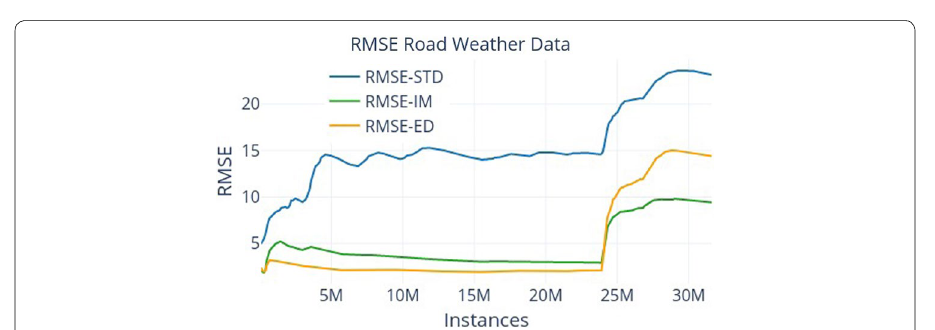
Fig. 6 RMSEs of road weather